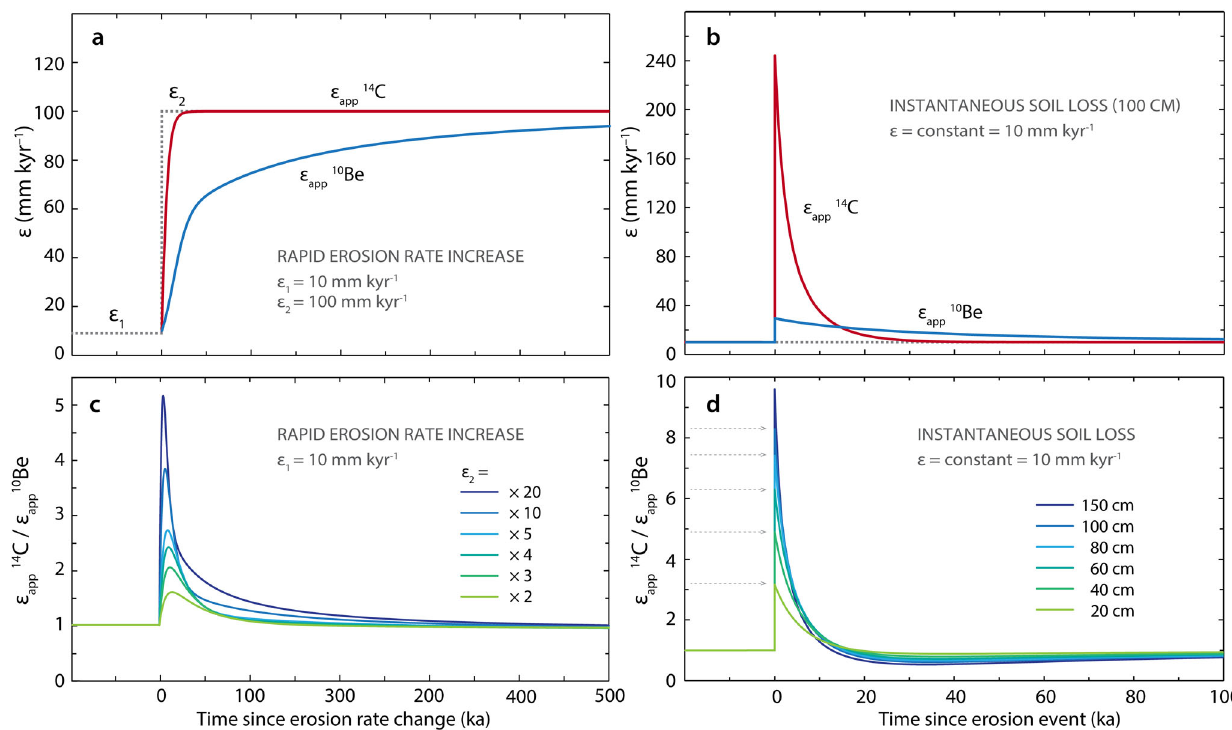
Fig. 2 Sensitivity of the 14 C- 10 Be chronometer for detecting landscape transience. Thanks to their differing half-lives, apparent erosion rates ( ε app ) calculated from the measured 14 C and 10 Be surface concentrations will deviate in the case of a an acceleration in erosion rate (from ε 1 to ε 2 ), or b an instantaneous loss of a soil layer. As 14 C is more sensitive to the erosional perturbation, the ratio of apparent erosion rates ε app 14 C/ ε app 10 Be increases immediately after the perturbation ( c , d ). Such events are best detected over Holocene timescales and before 14 C re-establishes isotopic steady state (after ~20 kyr). For better visibility, arrows in d mark the maximum of the ε app 14 C/ ε app 10 Be for each given depth of